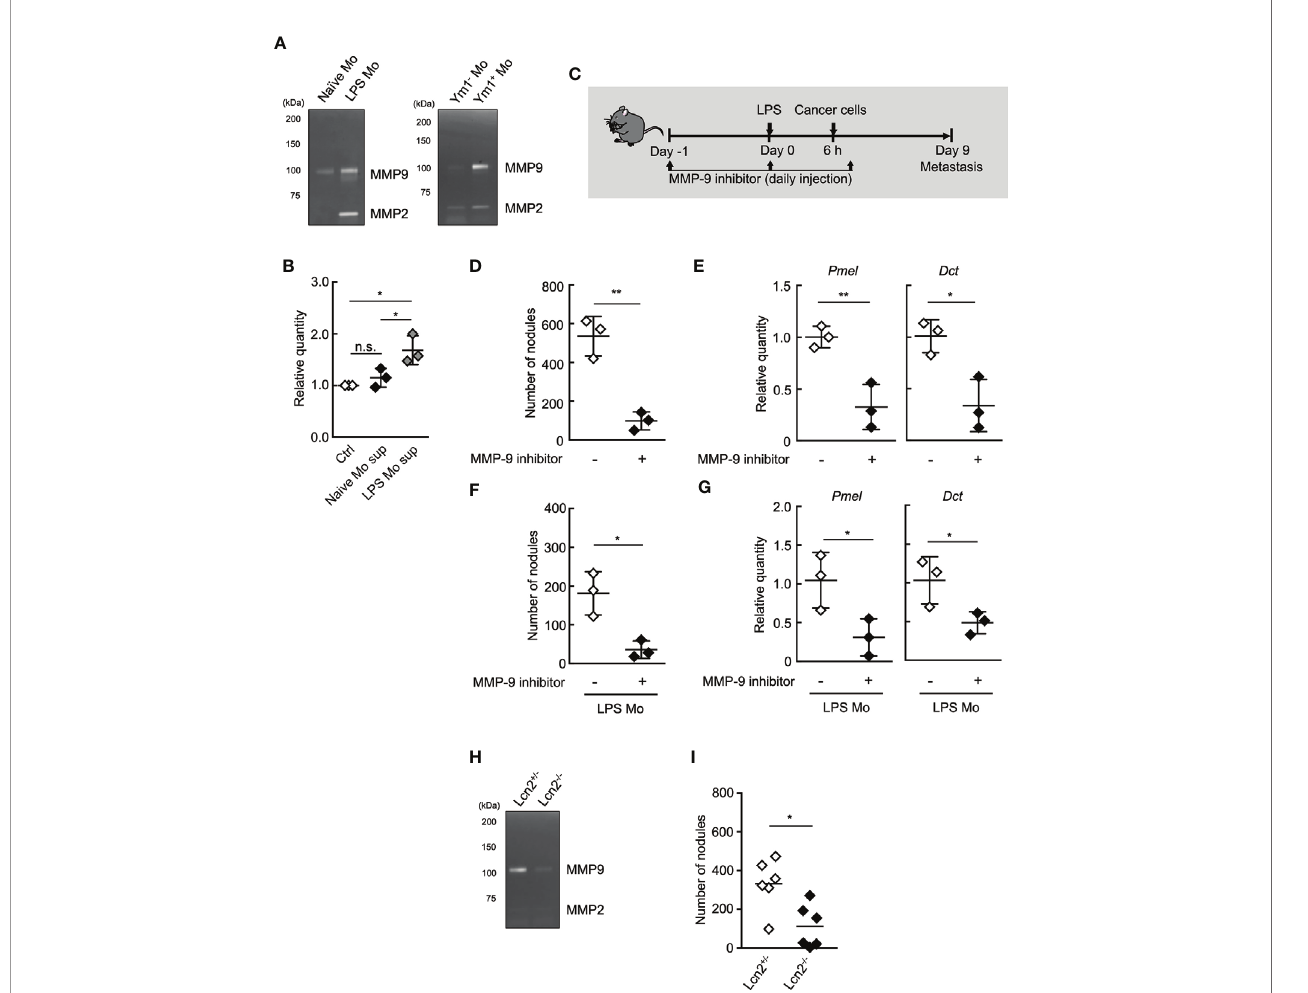
FIGURE 4 | MMP-9 is essential for Ly6C hi monocyte-promoting lung metastasis. (A) Gelatin zymography of culture supernatant of monocytes. Ly6C hi monocytes isolated from naïve- or LPS-treated WT mice (left), or Ym1 + or Ym1 - Ly6C hi monocytes isolated from LPS-treated Ym1-Venus mice (right) were cultured for 24 h. The culture supernatants were assayed for gelatinase activity. Experiments were repeated twice with similar results. (B) Invasion assay of cancer cells in the presence of culture supernatant of Ly6C hi monocytes isolated from naïve or LPS-treated WT mice. Average values are shown with SD. One-way ANOVA followed by Tukey ’ s test, n = 3. * P < 0.05; n.s., not signi fi cant. Each symbol represents an individual animal-derived culture supernatant. (C – E) Effects of MMP-9 inhibitor on LPS- promoted metastatic progression. (C) Experimental design used to test the effects of MMP-9 inhibitor injected at the early points of metastasis. WT mice were injected with 20 µg of LPS on Day 0 followed by i.v. injection of B16 cells (1 x 10 5 cells) 6 h later. These mice were injected with 10% DMSO/PBS [inhibitor (-)] or MMP-9 inhibitor (SB-3CT, 250 µg) on Day -1, 0, 1. The lungs were analyzed for metastasis on Day 9. (D) Quantitative summary of the number of lung metastases. (E) mRNA expression levels of indicated genes in lungs are shown as fold change relative to control lungs. Average values are shown with SD. Unpaired two-tailed t- test, n = 3. ** P < 0.01; * P < 0.05. Each symbol represents an individual animal. (F, G) Effects of MMP-9 inhibitor on metastasis promoted by LPS Mo transfer. WT mice were transferred intravenously with Ly6C hi monocytes prepared from LPS-treated mice (LPS Mo) (5 x 10 5 cells) on Day -1. Twenty-four hours later, B16 cells were injected intravenously. These mice were injected with 10% DMSO/PBS [inhibitor (-)] or MMP-9 inhibitor (SB-3CT, 250 µg) on Day -1, 0, 1. The lungs were analyzed for metastasis on Day 9. (F) Quantitative summary of the number of lung metastases on Day 9. (G) mRNA expression levels of indicated genes in lungs are shown as fold change relative to control lungs. Average values are shown with SD. Unpaired two-tailed t-test, n = 3. * P < 0.05; n.s., not signi fi cant. Each symbol represents an individual animal. (H) Gelatin zymography of culture supernatant of Lcn2 -/- monocytes. Ly6C hi monocytes isolated from LPS-treated Lcn2 +/- or Lcn2 -/- mice were cultured for 24 h. The culture supernatants were assayed for gelatinase activity. Experiments were repeated twice with similar results. (I) Reduced number of metastatic foci in lung by the injection of Lcn2 -/- LPS Mo. LPS Mo were prepared from BM of Lcn2 +/- or Lcn2 -/- mice 48 h after LPS (20 µg) injection, and these monocytes were transferred intravenously into WT mice. Twenty-four hours later, B16 cells (1 x 10 5 cells) were injected intravenously. The lungs were analyzed for metastasis on Day 9. Average values are shown. Unpaired two-tailed t-test, n = 6. * P < 0.05. Each symbol represents an individual